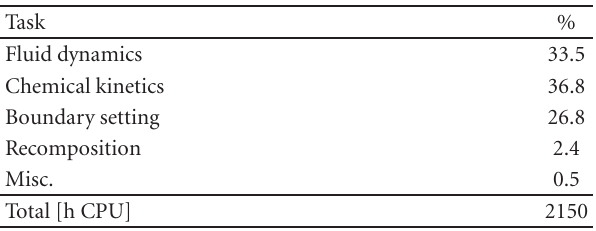
Table 1: Breakdown of computational time for the two- dimensional cellular structure simulation.